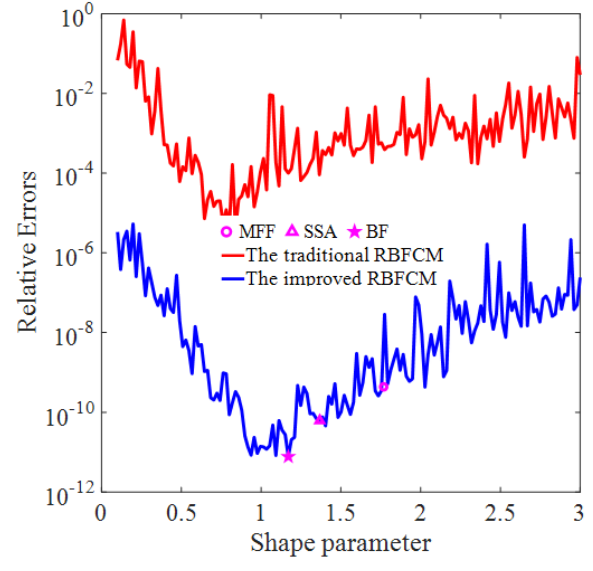
Figure 5. The numerical results versus the shape parameter.